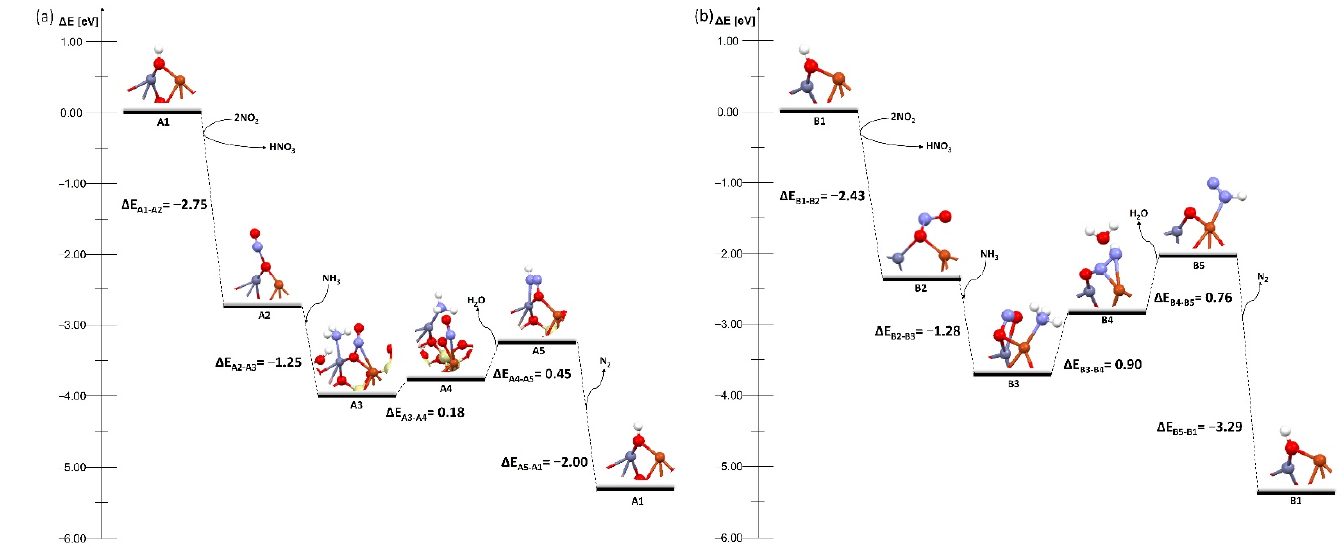
Figure 4. Energy diagram of proposed mechanism of deNOx in the Cu–O–Zn dimer supported on ( a ) bimetallic dimer on FAU and ( b ) bimetallic dimer on MFI with bridged OH group on both zeo- lites.